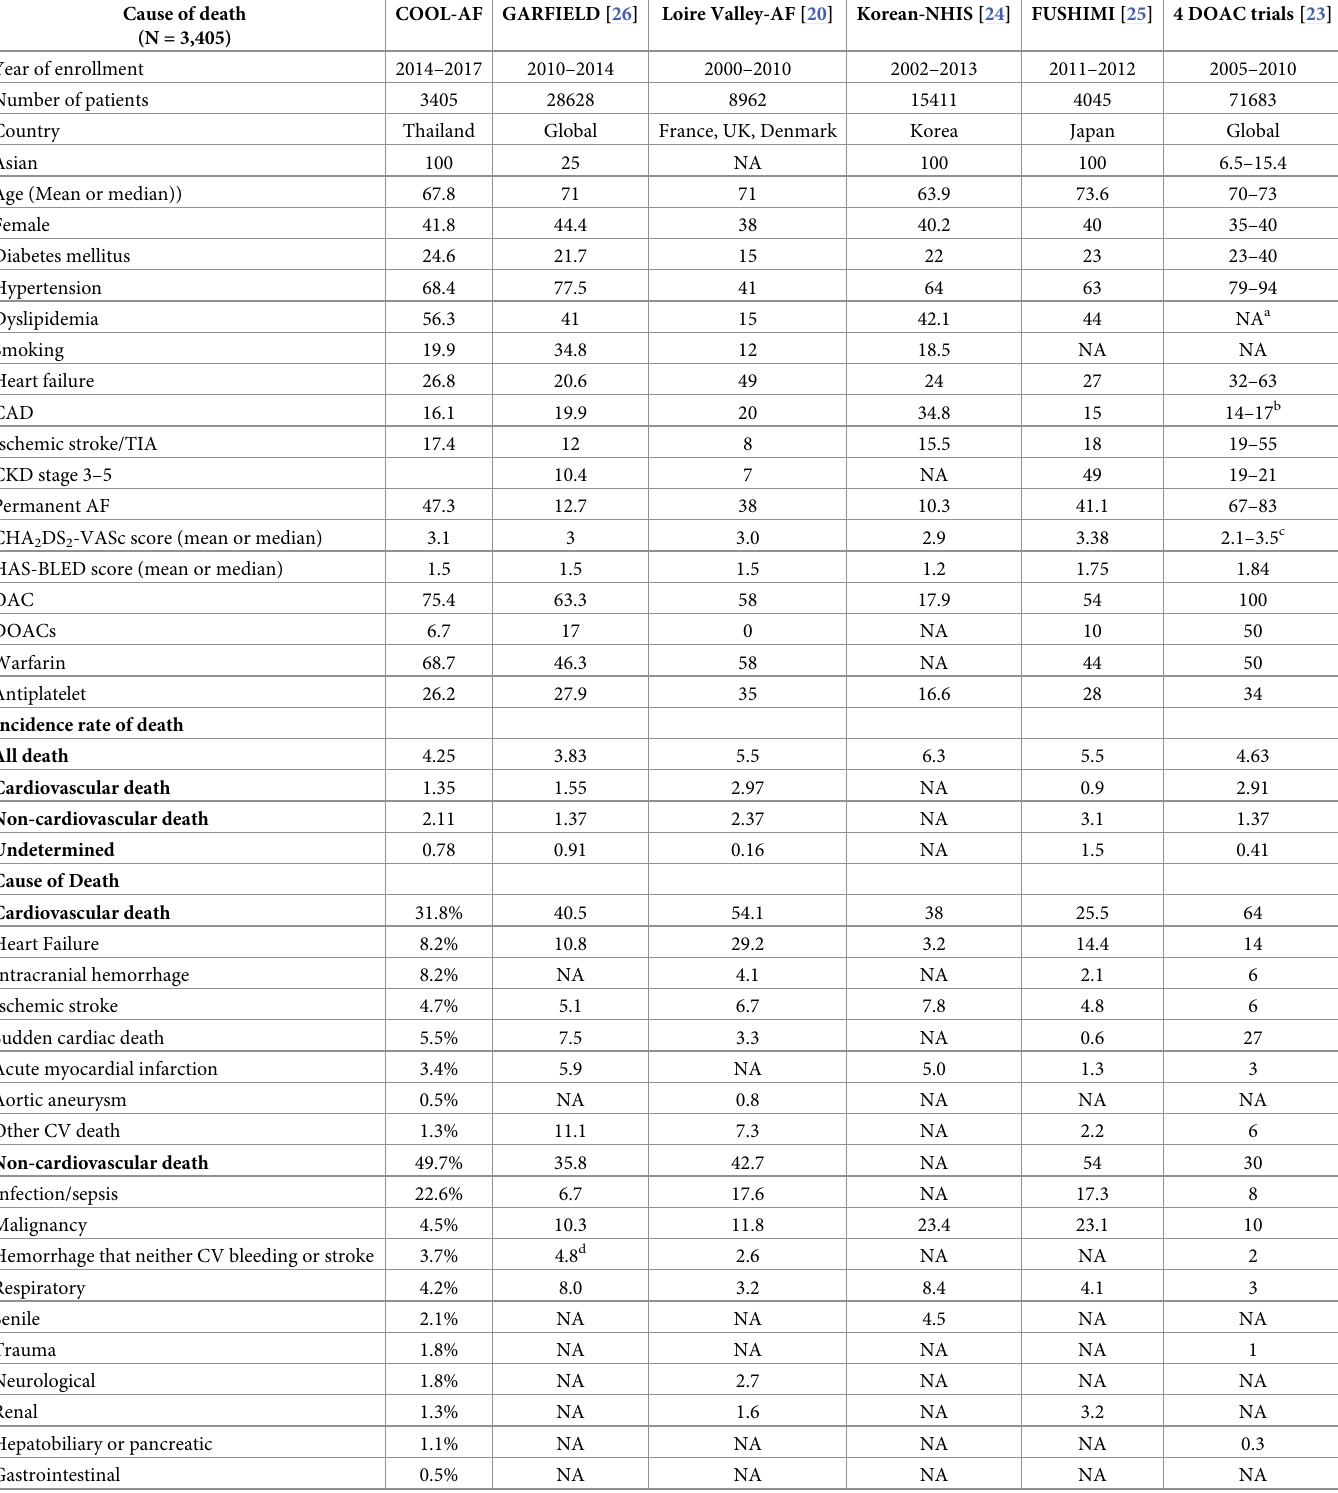
Table 3. Cause of death of patients with atrial fibrillation from COOL-AF study compared to some of the previously published data. Cause of death (N =